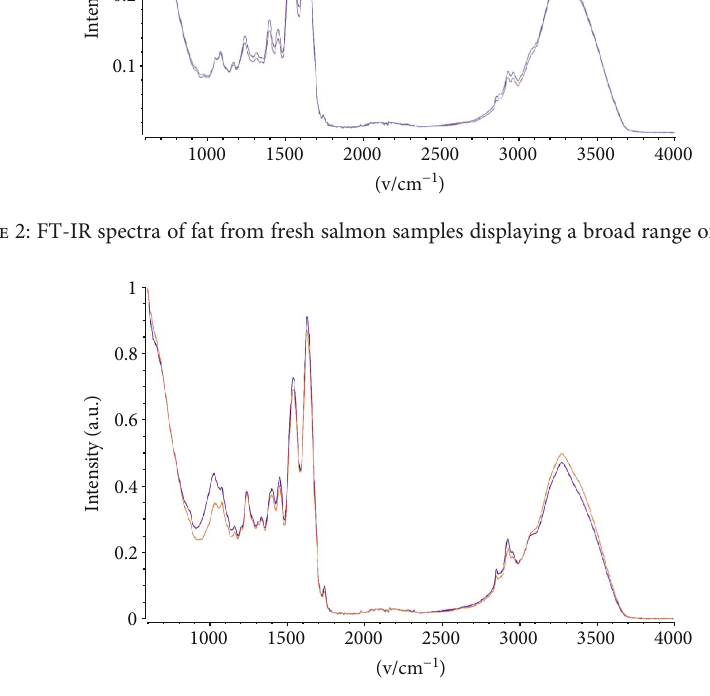
Figure 3: FT-IR spectra of the outer skin surface from fresh salmon sampled on two di ff erent